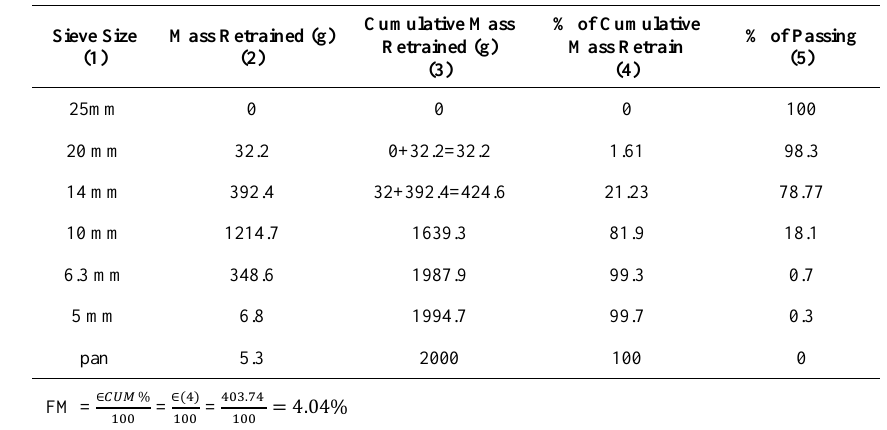
Figure 15. Experimental programme Sieve analysis test results for normal and recycled coarse aggregate are presented in Tables 2 and 3. Table 2. Sieve analysis for normal coarse aggregate